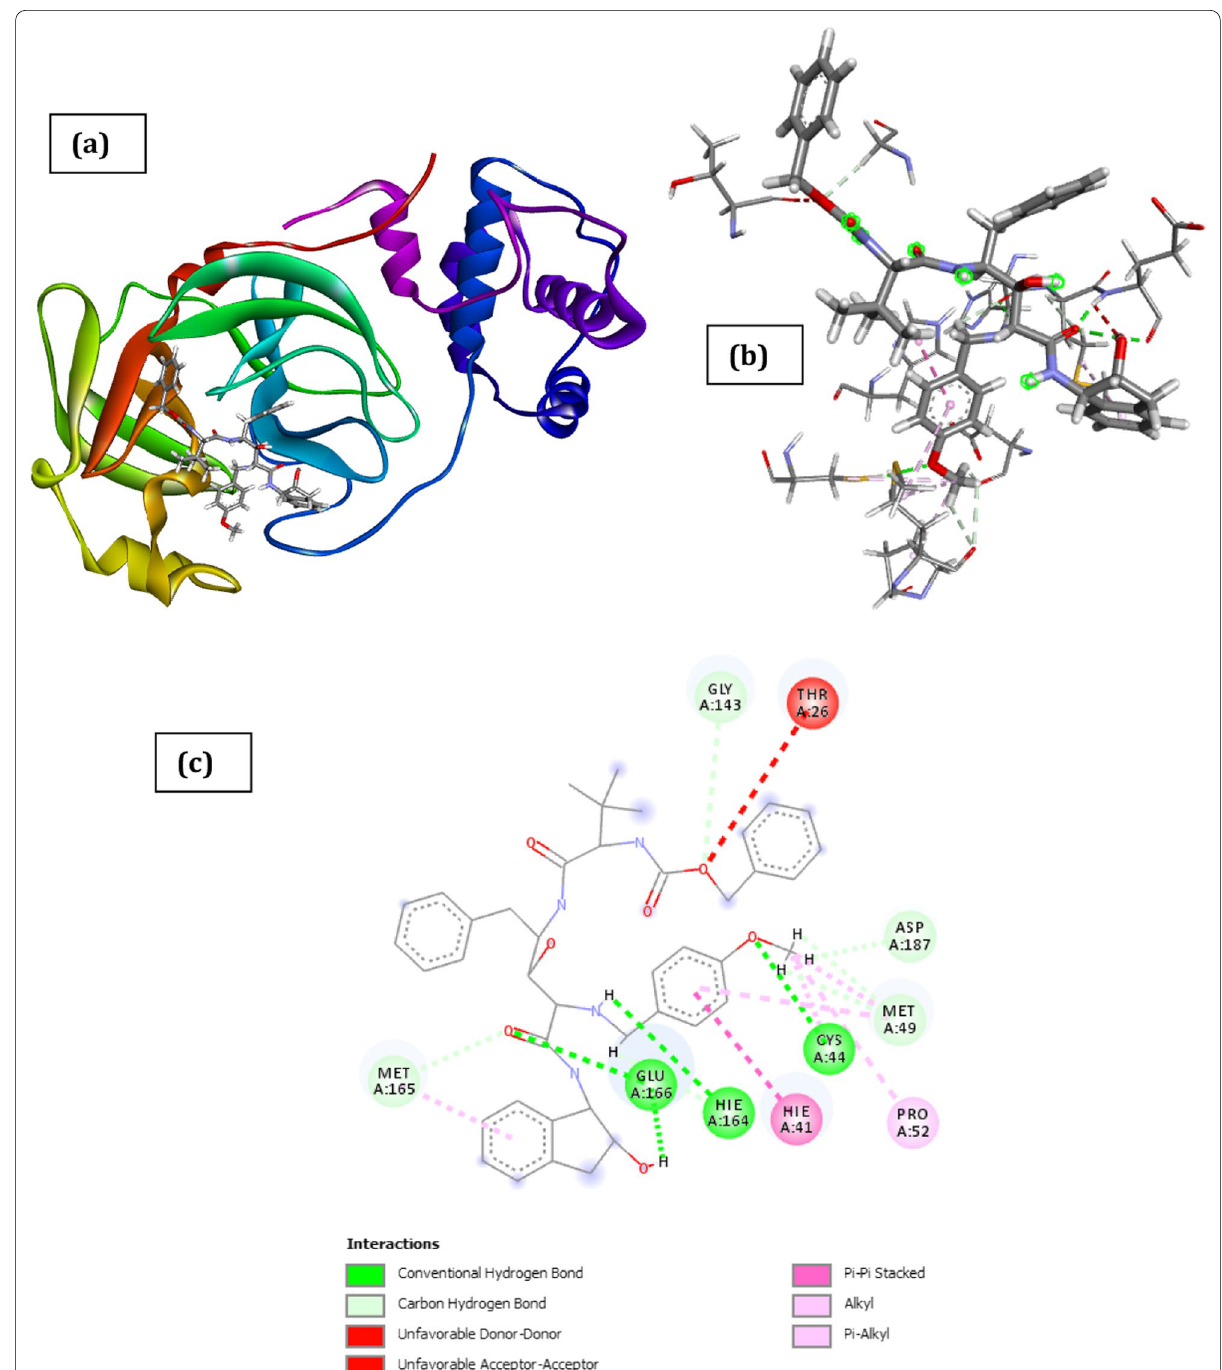
Fig. 6 Docked poses of SARS CoV 2 main protease (PDB ID: 6XBH) with inhibitor with Index number 819 (stick figure) a 3D view of docked pose of SARS CoV 2 Main Protease (PDB ID: 6XBH) with inhibitor with Index number 819; b 3D view of inhibitor with Index number 819 with surrounding amino acids of 6XBH; c 2D view of interaction type of inhibitor with Index number 819 with surrounding amino acids of